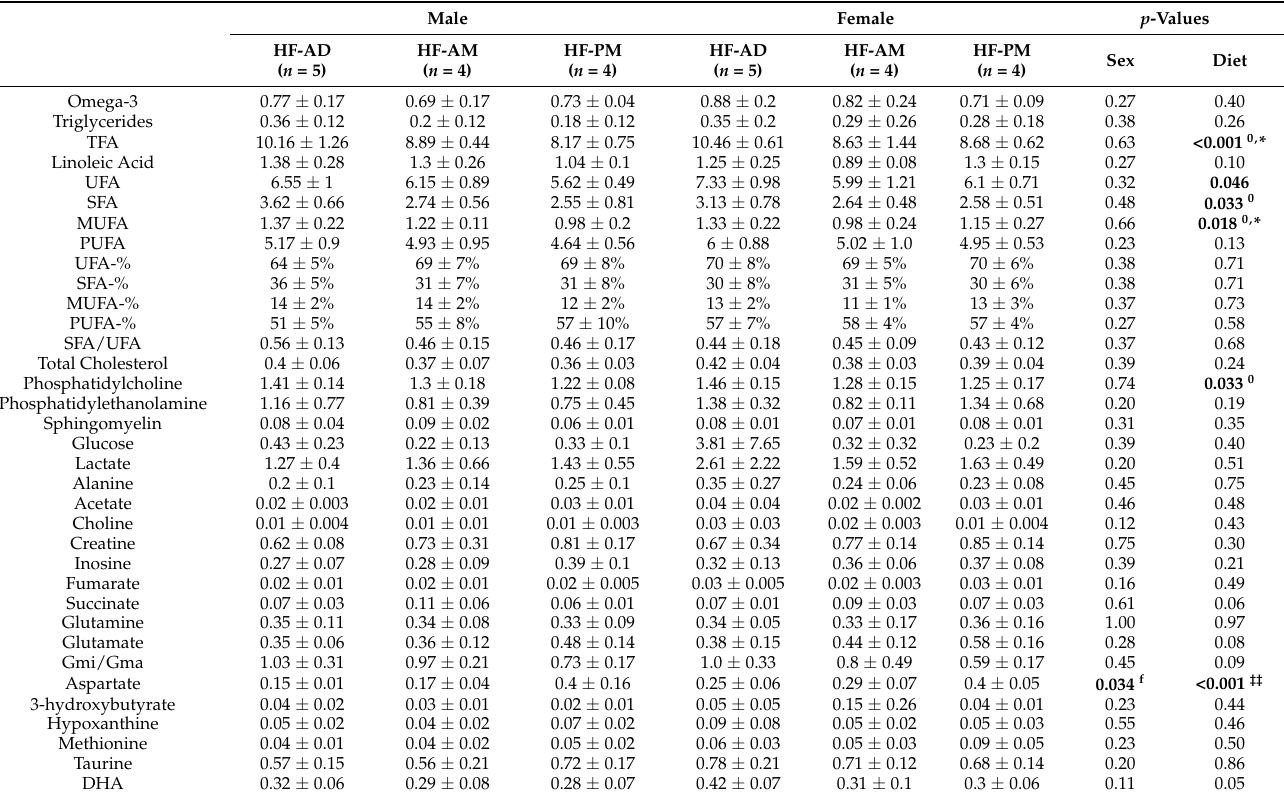
Table 4. Cardiac metabolite concentrations (mM) indicated as mean ± standard deviation for both male and female high-fat ad libitum (HF-AD), high-fat morning time-restricted (HF-AM), and high-fat evening time-restricted (HF-PM) groups.